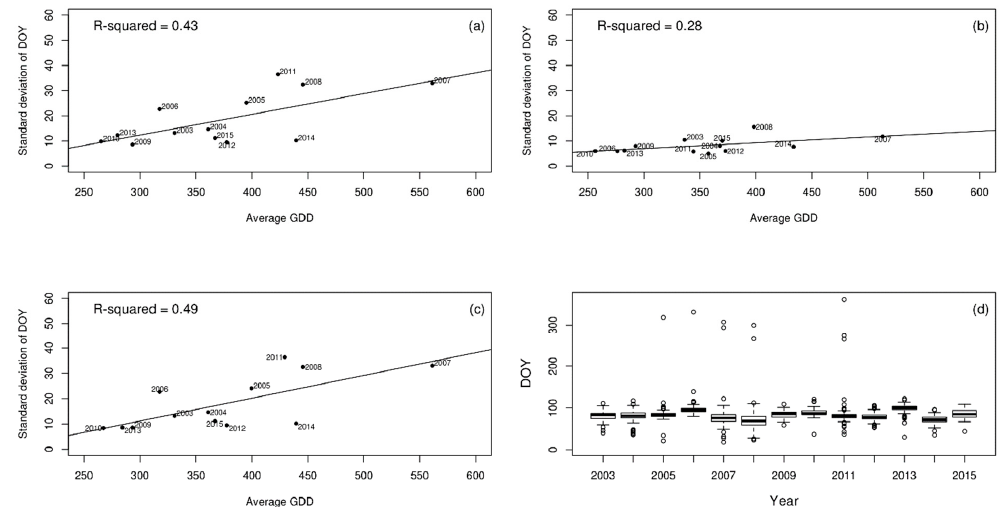
Figure A9. Wood anemone flowering onset synchrony models for ( a ) original, ( b ) outlier-free and ( c ) consistent observations. Panel ( d ) shows annual boxplots of the reported DOYs for the original observations.